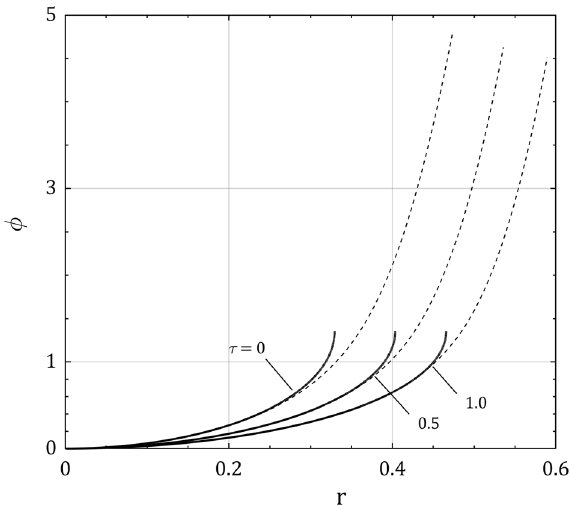
10 and τ 0 , 0.5 and 1.0 in plasma space r . The = =